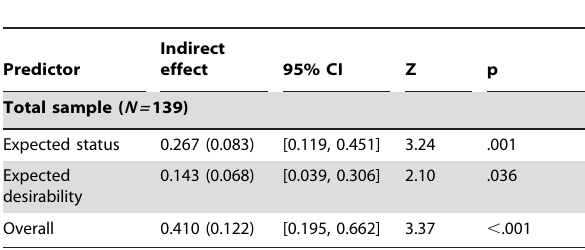
Table 2. Results Testing if Expected Status and Expected Desirability Mediated Tendency to Flaunt or